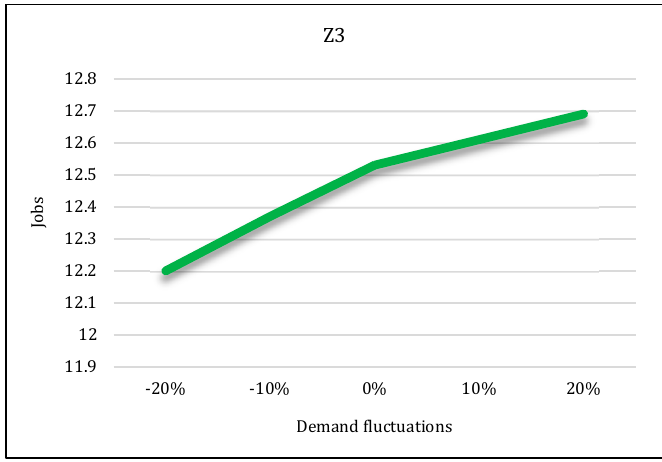
Figure 29. Demand variation effect on third objective function.